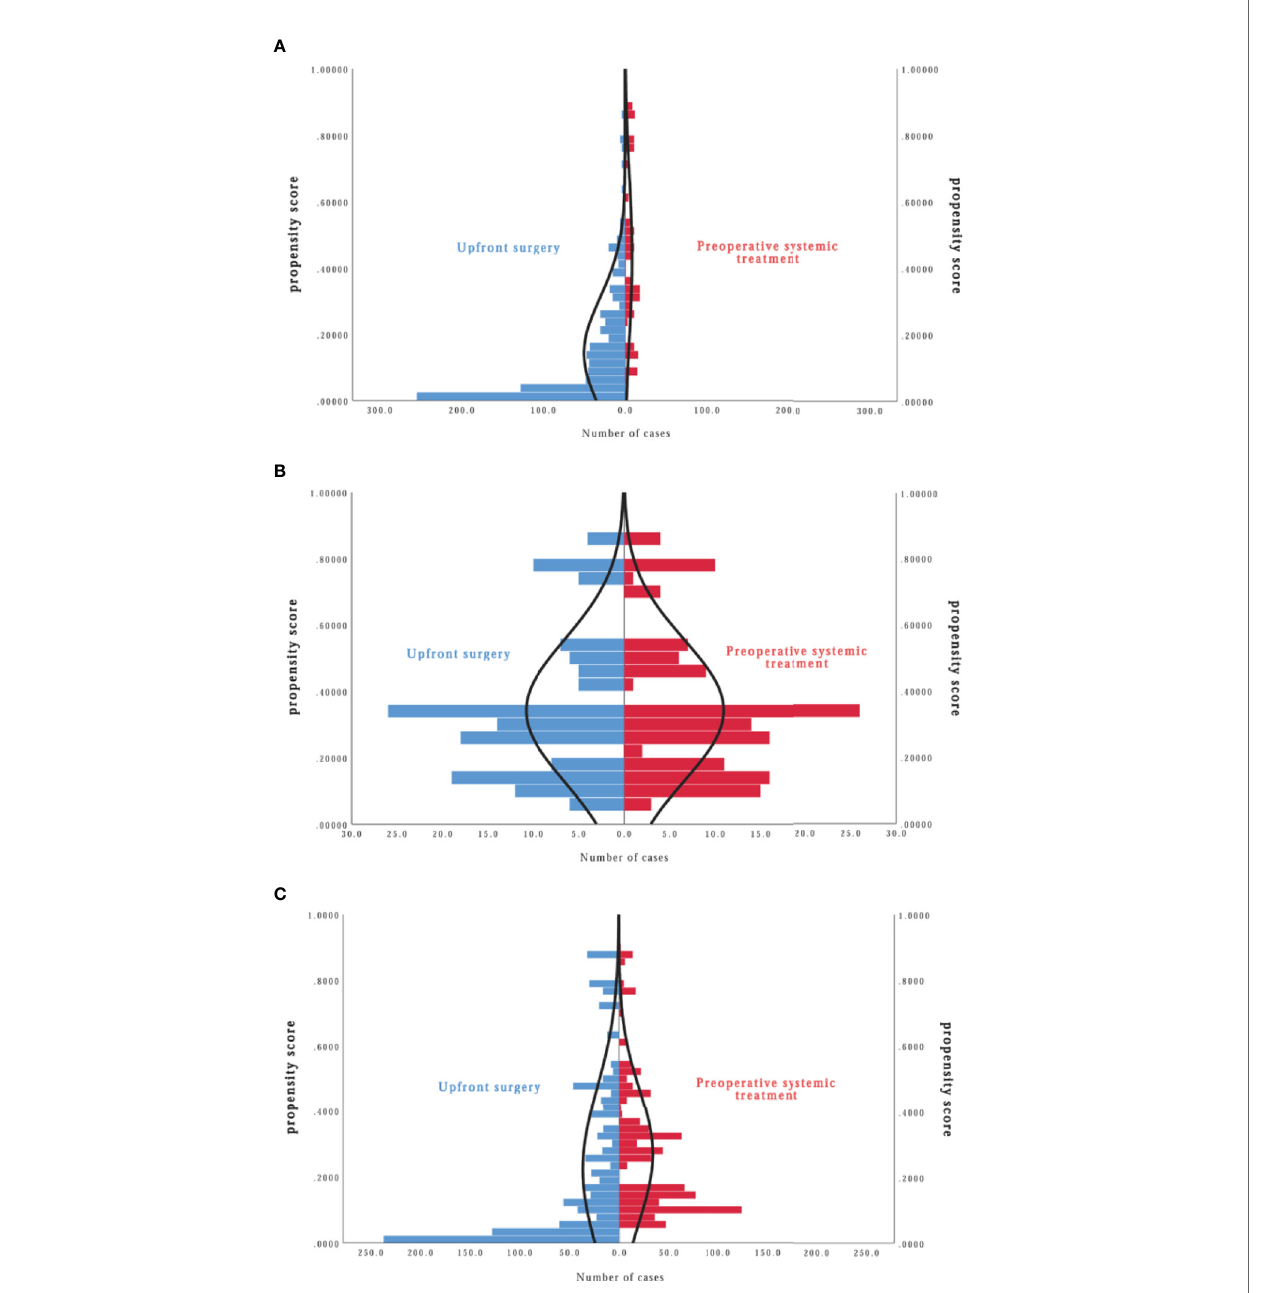
FIGURE 4 | Distribution cone diagram of propensity score in two groups in unmatched model (A) , in propensity score matching (PSM) model (B) , in inverse probability of treatment weighting (IPTW) model (C)